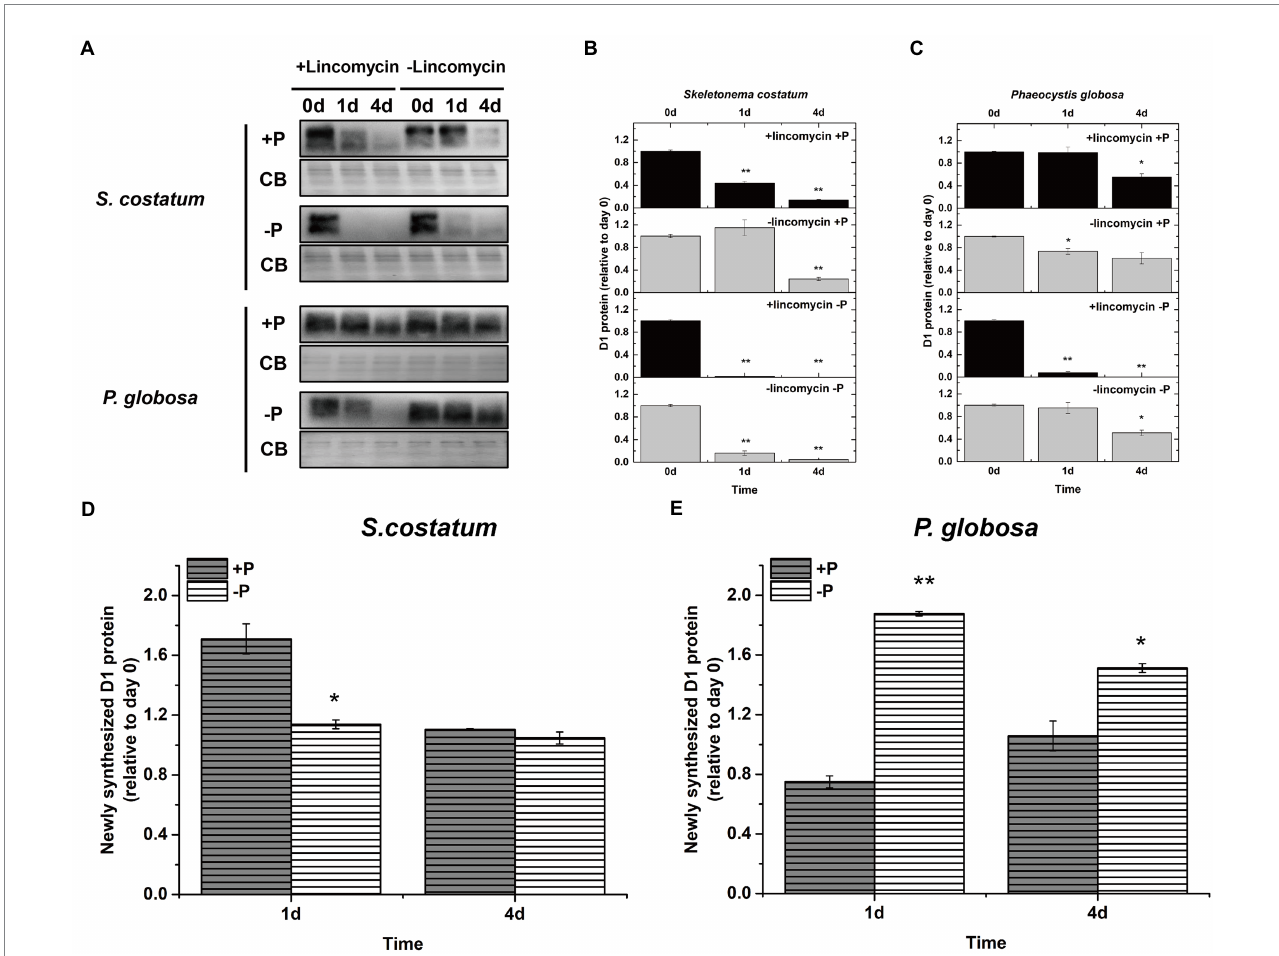
FIGURE 9 (A) Immunoblot analysis of D1 protein levels in S . costatum and P . globosa cultures treated with or without lincomycin in +P and − P groups. The blot was stained with Coomassie blue (CB). (B) Ratios of the D1 protein level of S . costatum cells semi-quantitated by the immunoblot analysis relative to that of cells on day 0, which was set to 100% for easy comparison. (C) Ratios of the D1 protein level of P . globosa cells semi-quantitated by the immunoblot analysis relative to that of cells on day 0. (D) Newly synthesized D1 protein (relative to day 0) in S . costatum in +P and − P groups. Newly synthesized D1 in PSII repair was measured as the change in the active D1 content in the absence of lincomycin (PSII repair active) minus the change in the active D1 content in the presence of lincomycin (PSII repair blocked). (E) Newly synthesized D1 protein (relative to day 0) in P . globosa in +P and − P groups. Newly synthesized D1 in PSII repair was measured as the change in the active D1 content in the absence of lincomycin (PSII repair active) minus the change in the active D1 content in the presence of lincomycin (PSII repair blocked). Error bars are mean ± SE of triplicate treatments. Superscripts indicate significant differences according to a two-way ANOVA with a post-hoc test ( B,C : day 0 vs. other days; D,E : +P group vs. − P group. ** p < 0.01, * p <